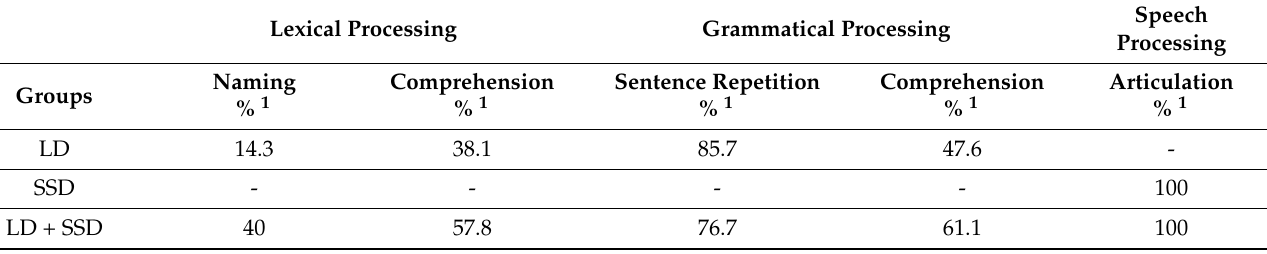
Table 1. Percentages of children with LD, SSD, LD + SSD who obtained clinical scores in Naming, Comprehension, Sentence Repetition, Comprehension, and Articulation subtests (BVL 4–12).